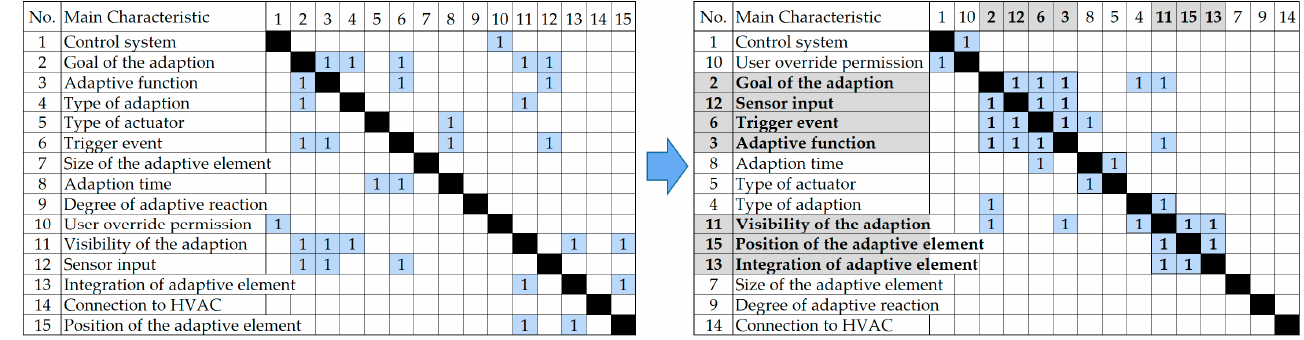
Figure 9. Deriving the dependencies between the main characteristics, adapted from [24].